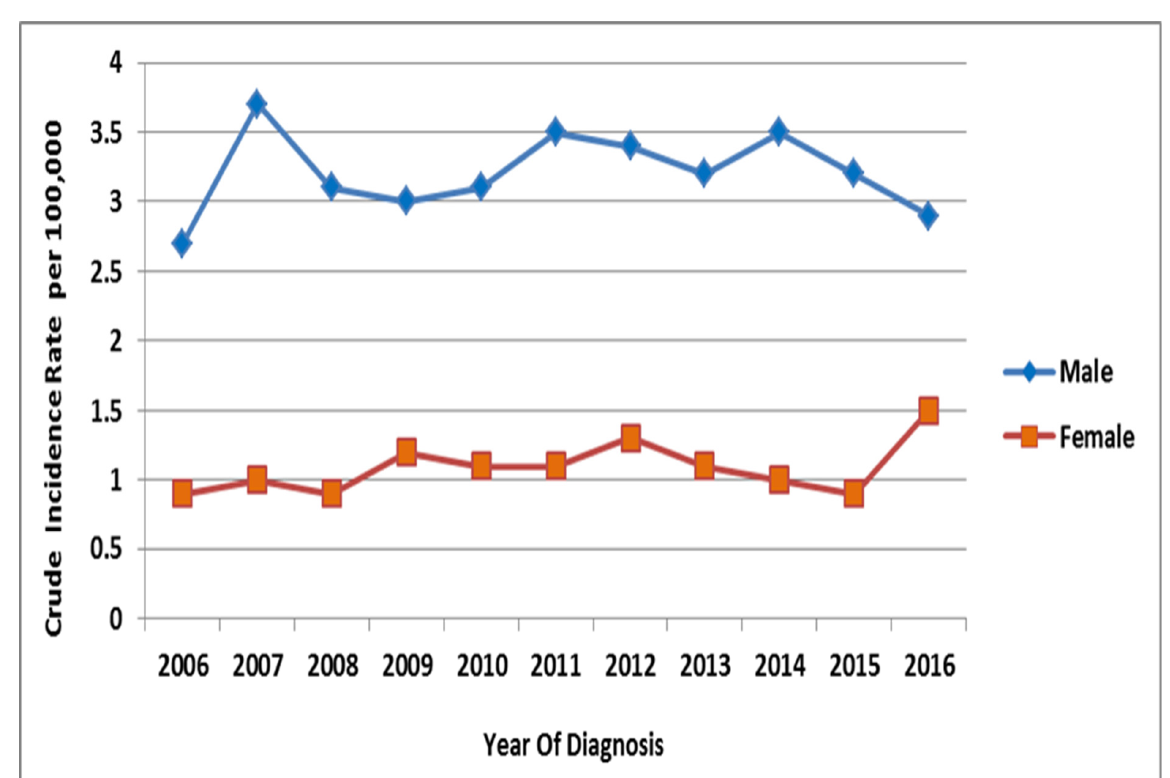
Figure 4. Crude incidence rate (CIR) of lung cancer per 100,000 among males and females during 2006 to 2016.